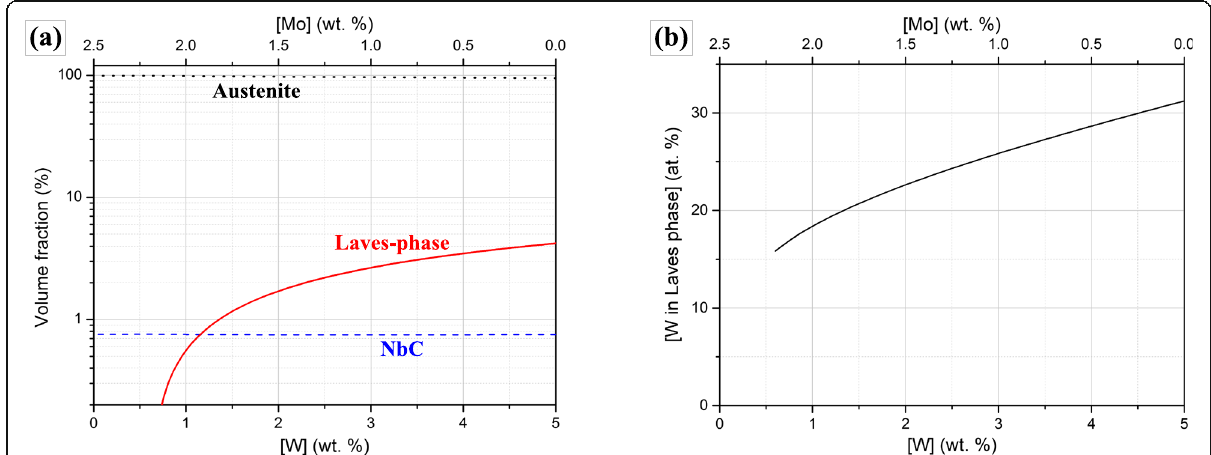
Fig. 7 Thermodynamic equilibria in the substrate with the target composition (Mo eq = 2.5) at 1053 K according to nominal W content: a phase equilibria, b equilibrium W content in Laves phase (note that the calculation with instable Laves-phase is indicated)